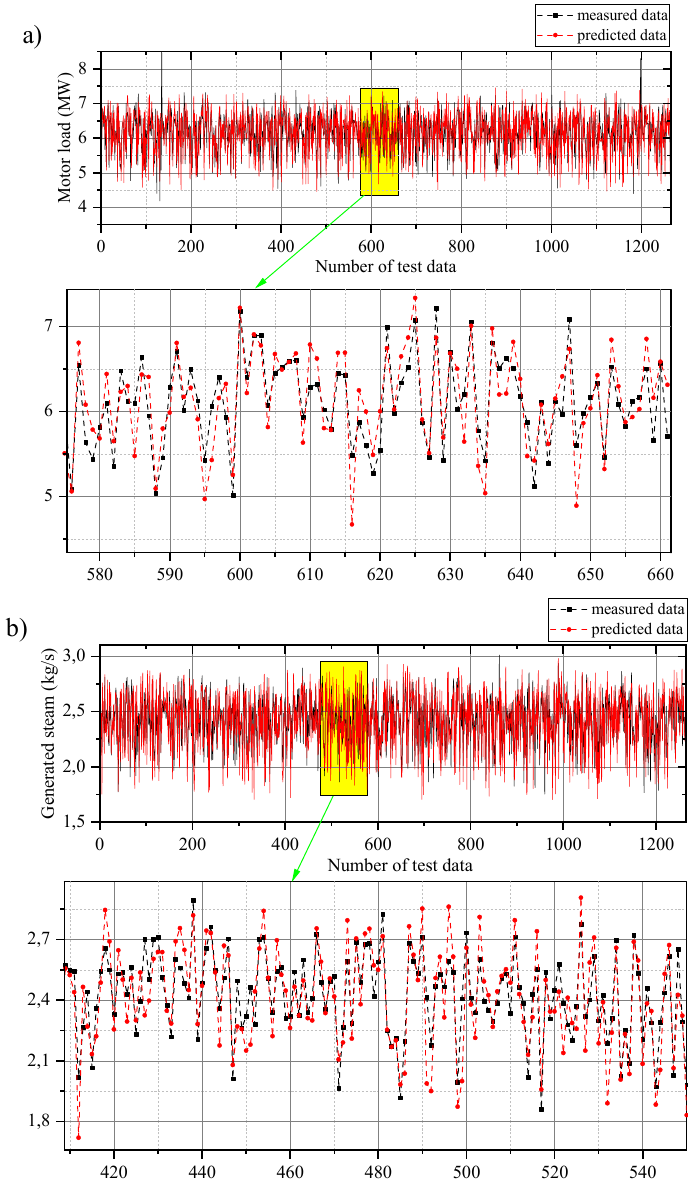
Figure 18. Test samples of differential evolution (DE) to estimate refining motor load ( a ), and refining steam generation ( b ).